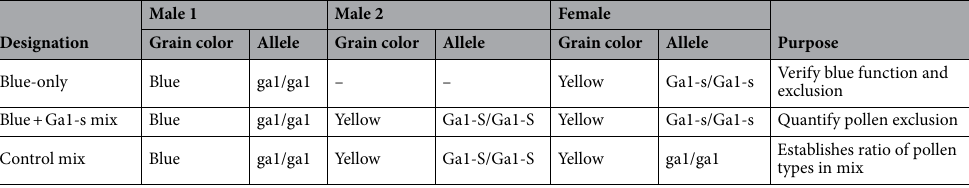
Table 1. Three types of pollinations performed in this